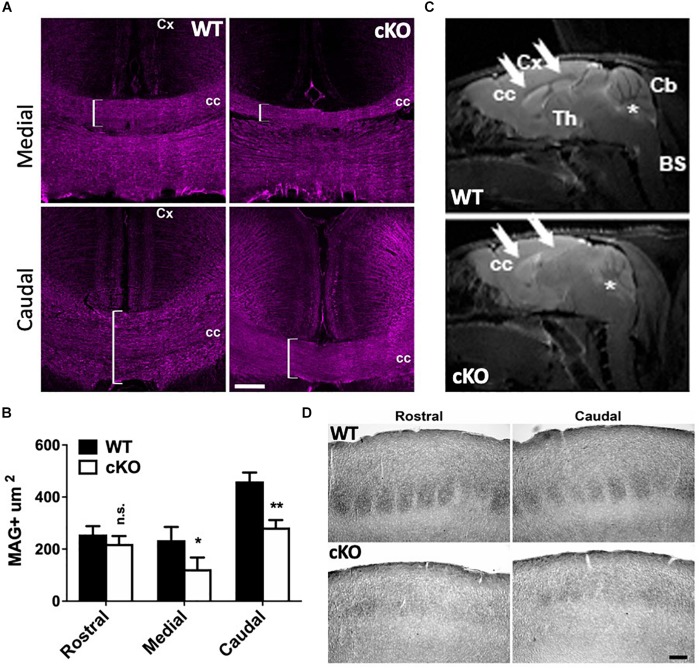
Corpus callosum dysgenesis and disrupted targeting of callosal projection neurons. (A) P40 medial and caudal coronal sections through the CC of mutant and control mice immunolabeled for myelin-associated glycoprotein (MAG; magenta), a marker of myelinated axonal fibers. Note the reduction of MAG+ fibers in the medial and caudal mutant brain (brackets). Cc, corpus callosum; Cx, cortex. Scale bar, 100 μm. (B) Quantitation of MAG+ areas through the corpus callosum at P40. 5 cubic bins were scored and averaged per section. Values are presented as the mean ± SEM. ∗P < 0.05, ∗∗P < 0.01, Student’s t-test, n = 3–4 sections per region per genotype. (C) Magnetic resonance imaging (MRI) of Snf2h cKO-Emx1 and control mice at P180 through the sagittal plane. Note the reduced white matter content (seen as gray) through the CC (arrows) in mutant mice relative to controls. Asterisks denote the cerebellum. CC, corpus callosum; Cx, cortex; Th, thalamus; Cb, cerebellum; BS, brain stem. 3 animals per genotype were scanned in 4 dimensional planes. (D) Brightfield images from P40 brains showing cytochrome oxidase staining through the somatosensory cortex. Note the altered barrel structures in the mutant cortex relative to controls. Scale bar, 100 μm.